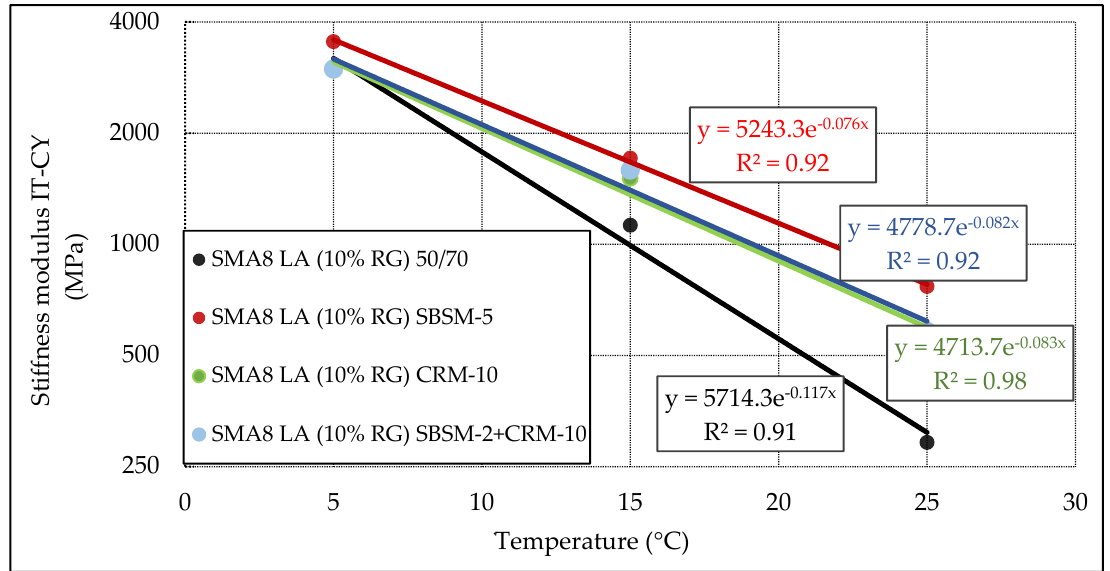
Figure 5. Stiffness modulus IT-CY of SMA LA8 and PA8 mixtures at 15 °C. Figure 5. Sti ff ness modulus IT-CY of SMA LA8 and PA8 mixtures at 15